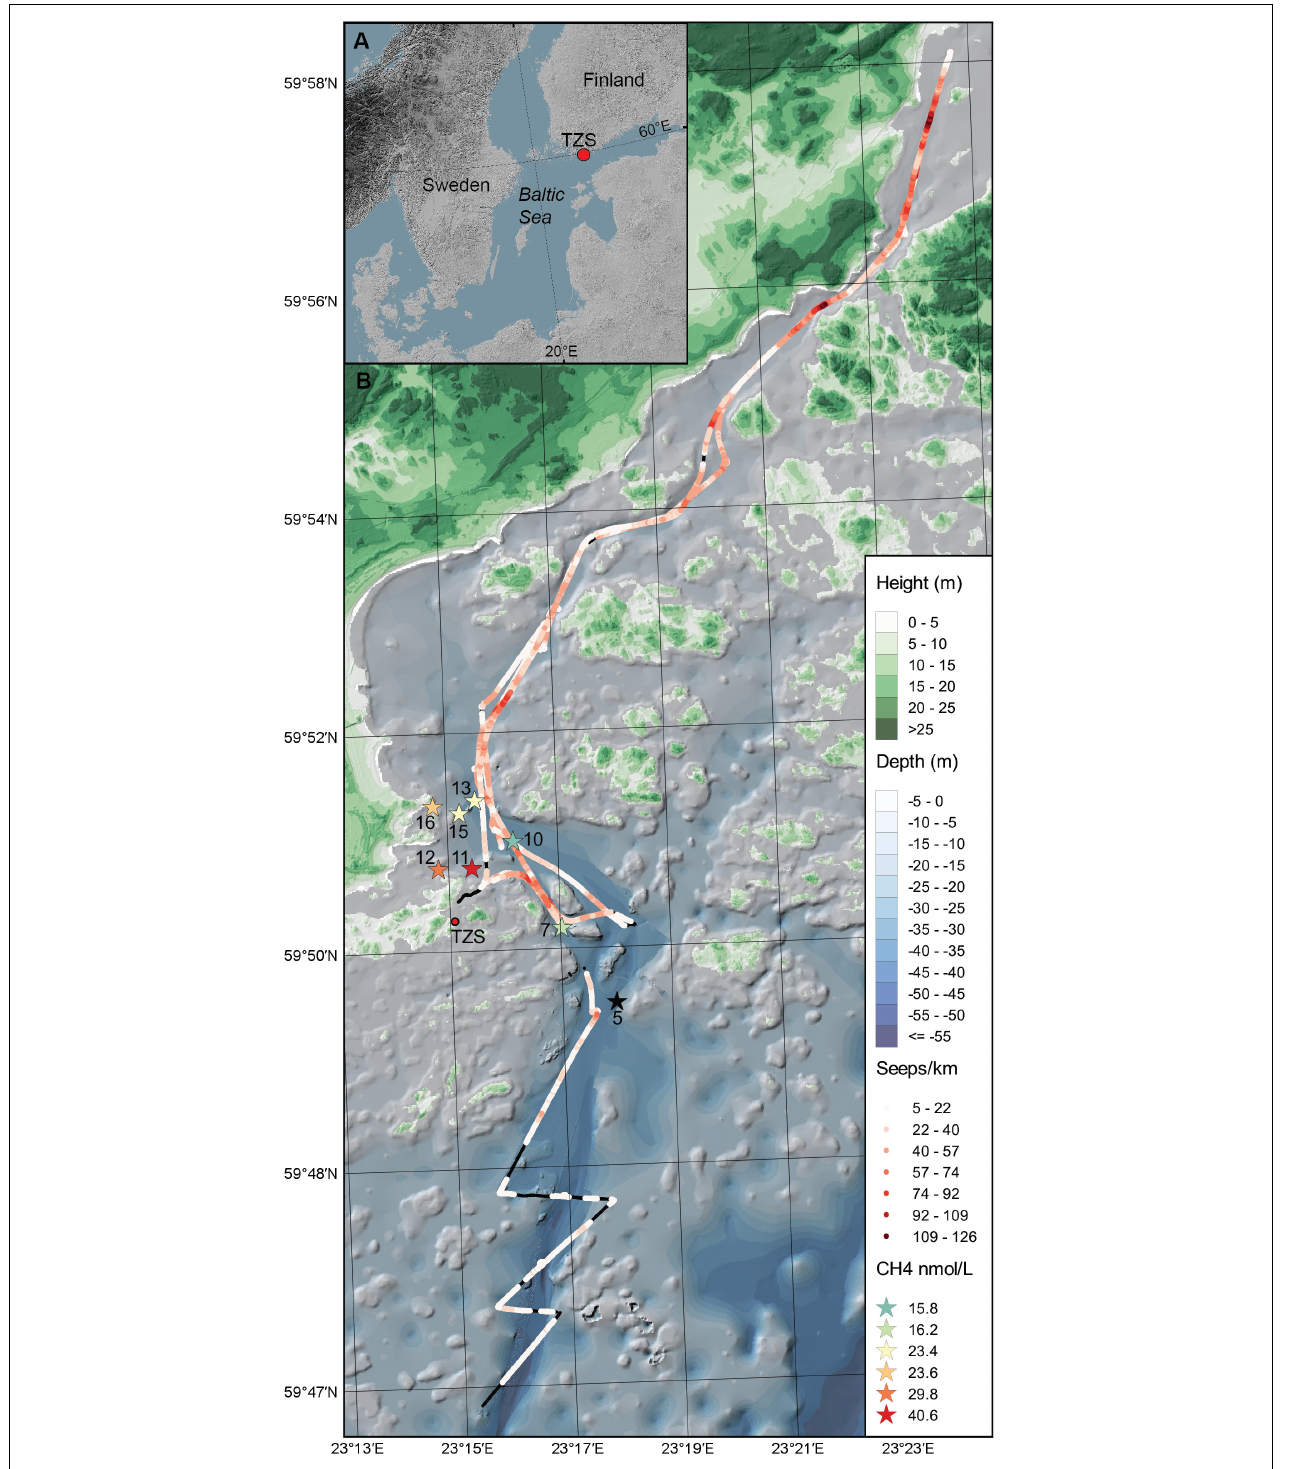
FIGURE 1 | (A) The map shows the Baltic Sea and the location of the study area in the Western Gulf of Finland. (B) Sediment was collected (top 0–2 cm surface) during June 2017 and September 2018 from the eight sampling stations (denoted as stars with station number, n = 3 sediment cores per station) in the Storfjärden bay, close to the Tvärminne Zoological Station (TZS). The red colored gradient of the stars shows the CH 4 concentration in the surface water for each station (0.5–1.0 m, for station five no CH 4 data was collected). The red-colored gradient line on the map shows the cruise track and number of CH 4 seeps km − 1 observed with acoustic data in the bottom water above the sediment. Black lines on the cruise track denotes no CH 4 seeps observed. The blue gradient denote water depth (m) and the green gradient terrestrial land height (m).